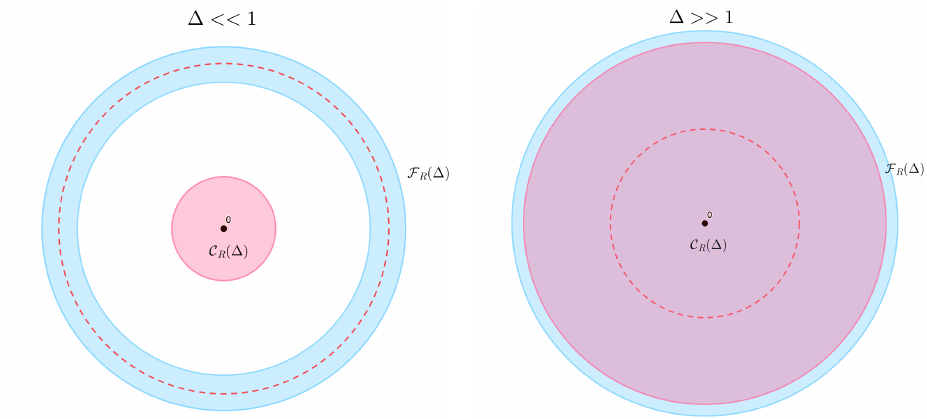
Figure 2. A sketch showing the difference in the quantities Z R ( ∆ ) and C R ( ∆ ) . The red dotted line represents the normalised tensors. The blue shaded area represents the area counted by Z R ( ∆ ) , and the red shaded area represents the area counted by C R ( ∆ ) . On the left we take ∆ (cid:28) 1, and on the right we take ∆ (cid:29)